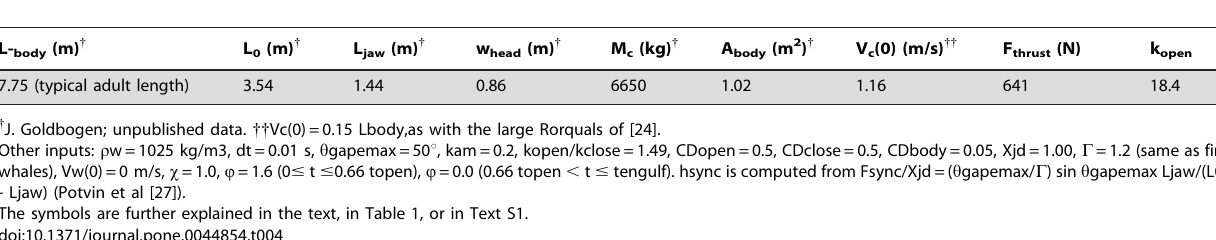
Table 4. BLF3 simulation inputs – minke